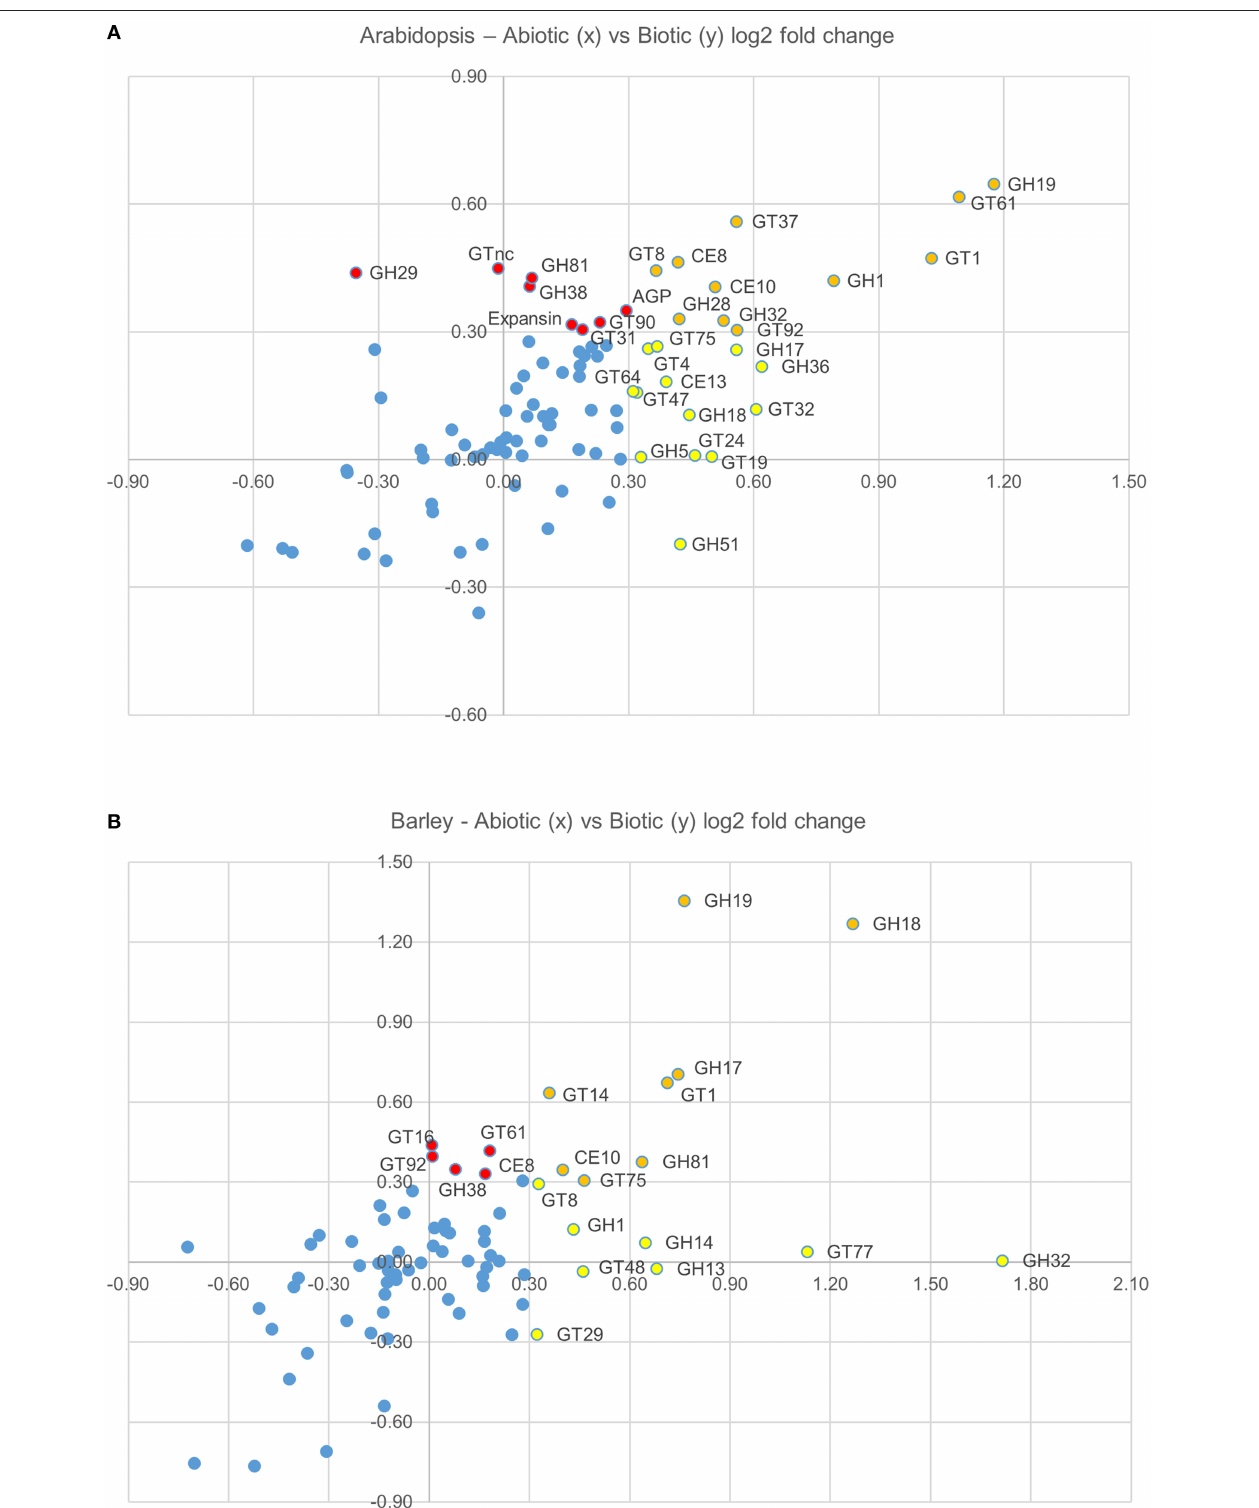
FIGURE 2 | Graphical representation the average log(2)-fold induction for each gene family (presented in Figure 1C), which shows the average abiotic ( x axis) and average biotic ( y axis) stress response in Arabidopsis (A) and barley (B). CAZy families that are upregulated in response to abiotic stresses, but not biotic stresses are colored red, CAZy families that are upregulated in response to biotic stresses, but not abiotic stresses are colored yellow, and CAZy families that are upregulated in response to both abiotic and biotic stresses are colored orange.